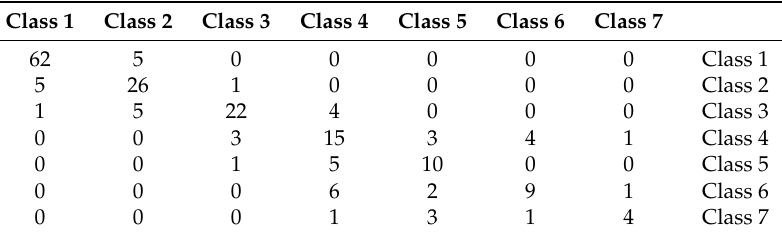
Table 6. Confusion matrix for the grouped classes of results.